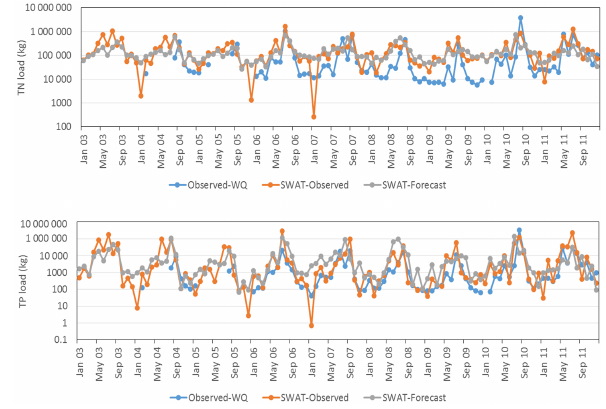
Figure 8. Comparison of observed pollutant loads (Observed-WQ), simulated pollutant loads using observed weather data (SWAT- Observed), and simulated pollutant loads using forecasted MME data (SWAT-Forecast) at Wecheon-B water quality monitoring sta-